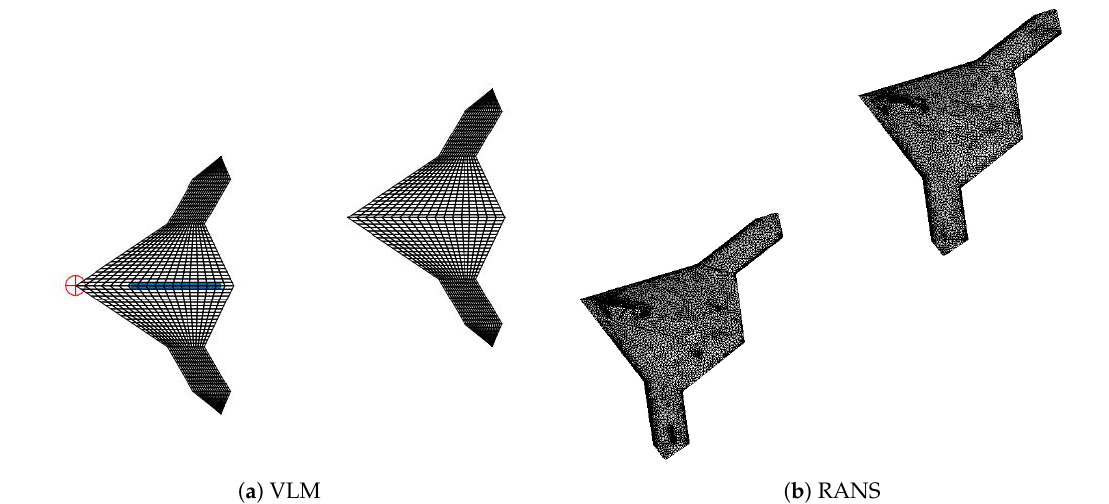
Figure 14. Panel distribution and surface gird distribution on the blended-wing-body two-aircraft